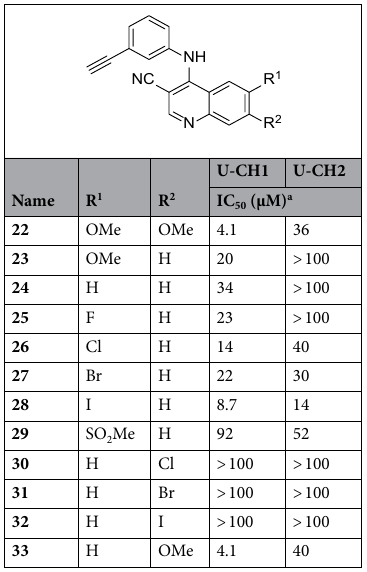
Table 2. Initial screening of 3-cyanoquinolines against chordoma cell lines. a Cell viability assay (n = 4).